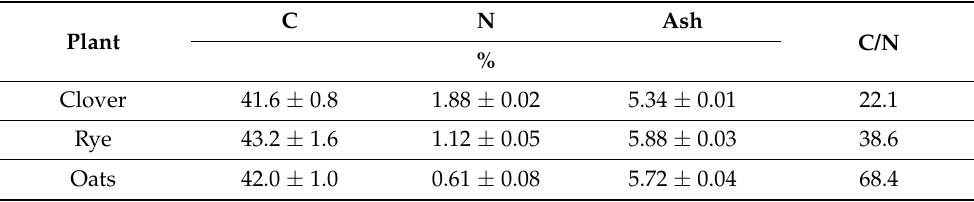
Table 1. Concentration of C, N, and ash, in plant material. C N Ash Plant C/N % Clover 41.6 ± 0.8 1.88 ± 0.02 5.34 ± 0.01 22.1 Rye 43.2 ± 1.6 1.12 ± 0.05 5.88 ± 0.03 38.6 Oats 42.0 ± 1.0 0.61 ± 0.08 5.72 ± 0.04